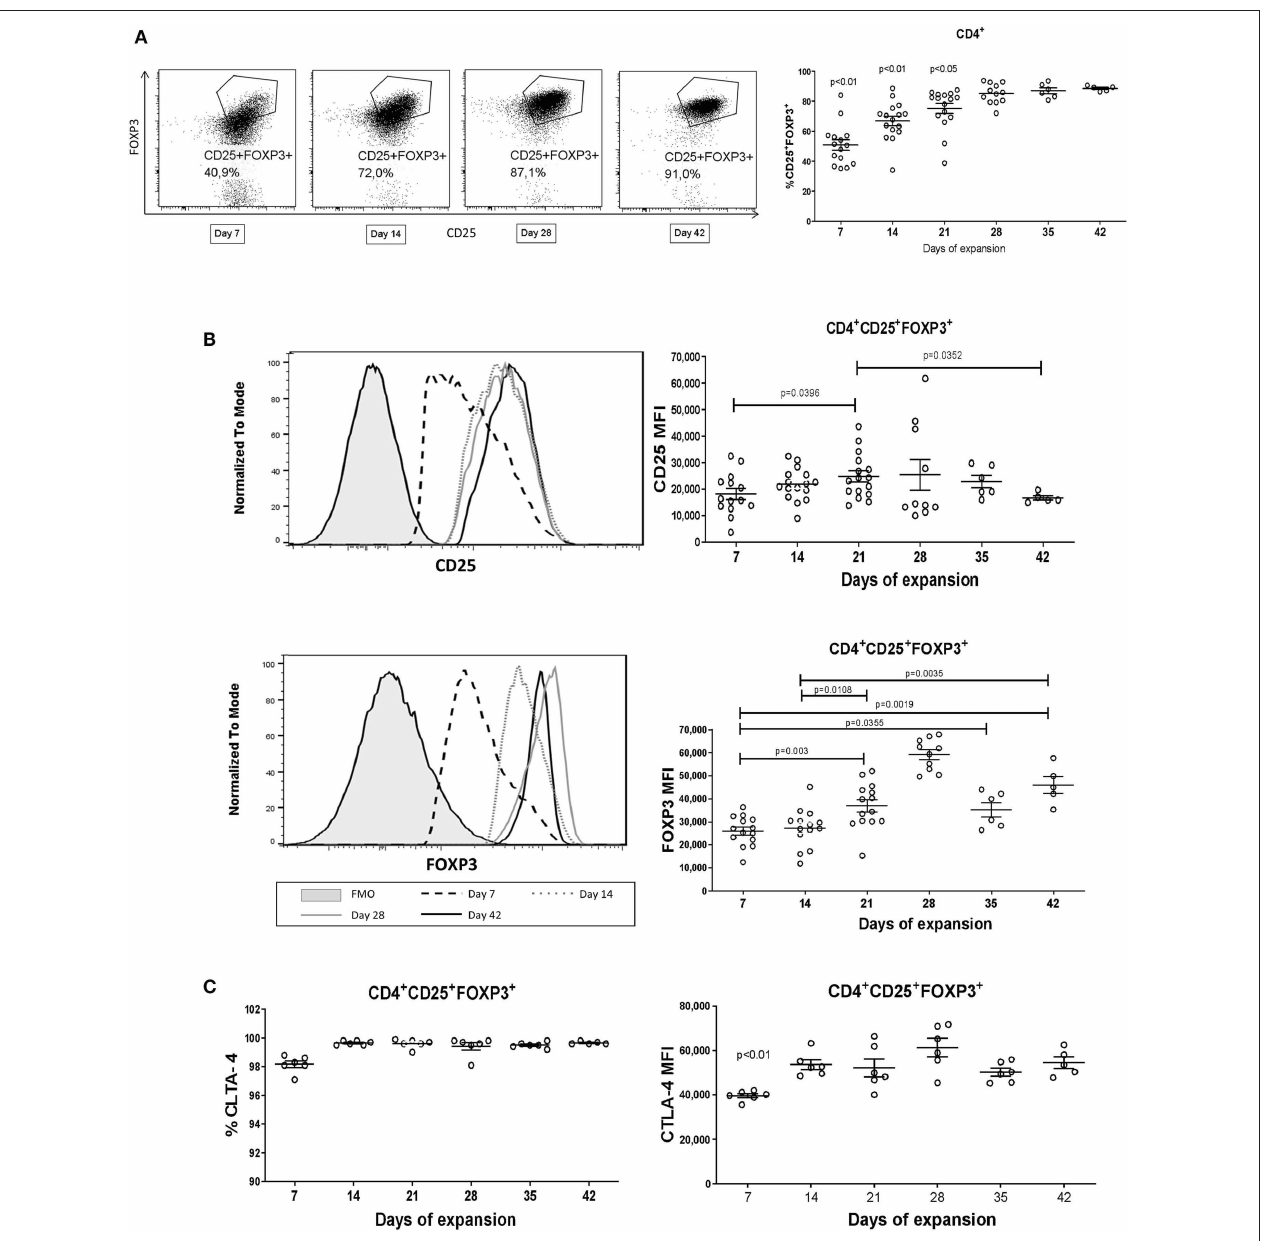
FIGURE 3 | Long-term expansion of iTregs increases the proportion of CD25 + FOXP3 + and expression of FOXP3. (A) Representative dot plots of allospecific CD25 + FOXP3 + iTregs expanded for 7, 14, 28, and 42 days. The percentage of CD4 + CD25 + FOXP3 + iTregs increased during the expansion culture reaching 90% at 42 days. (B) Increase in the expression of CD25 and FOXP3 (left graphs) in expanded iTregs for 6 weeks. (C) The expanded iTregs were positive for CTLA-4 with intensity increases after the 2nd week of expansion. MFI values were calculated as above. Data represent the mean ± SEM from n = 5–14 donors from five independent experiments. The statistical analysis was performed using the non-parametric Mann–Whitney test, two-tailed. P < 0.05 was considered statistically